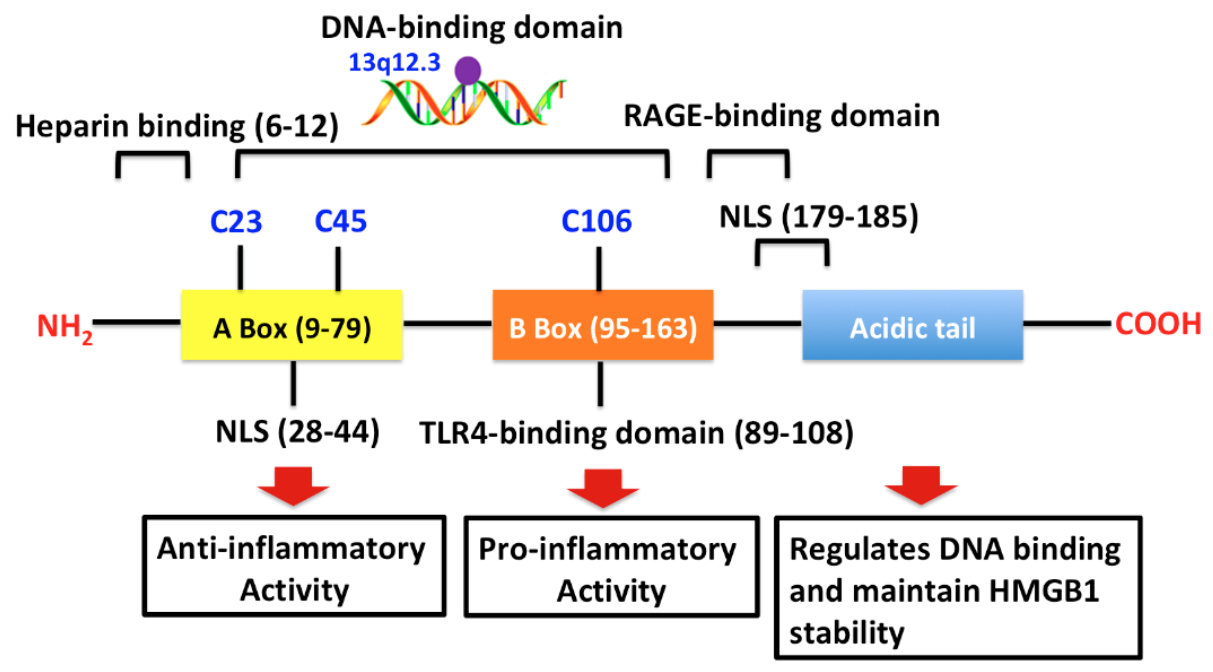
Figure 1. Structure of the HMGB1 protein. The HMGB1 protein comprises 215 amino acid residues and contains three regions: A-box, B-box and an acidic tail. Each region includes several functional domains: NLS, TLR4-binding domain, heparin-binding, RAGE-binding domain and DNA-binding domain. The domains exert different biological functions, such as anti-inflammatory activity, pro-inflammatory activity, regulation of DNA binding and stabilization of HMGB1. The A box mediates the anti-inflammatory functions of HMGB1; the B box, cytokine-mediated functions. Three key cysteines are also indicated (Cys106, Cys45 and Cys23). Abbreviations: HMGB1, high-mobility group box 1; NLS, nuclear localization sites; TLR, Toll-like receptor; RAGE, receptor for advanced glycation end products.